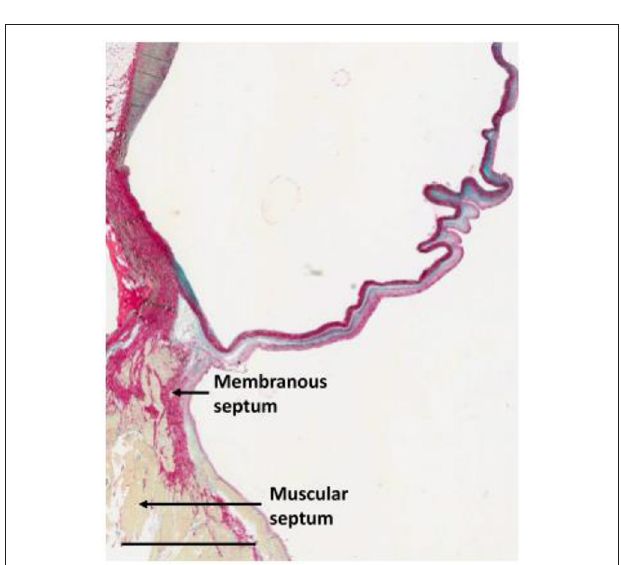
FIGURE 13 | Section through the anterior half of the non-coronary sinus approaching the interventricular septum illustrating the concept of the trilammellar sliding hypothesis. Scale bar is 3mm (107).